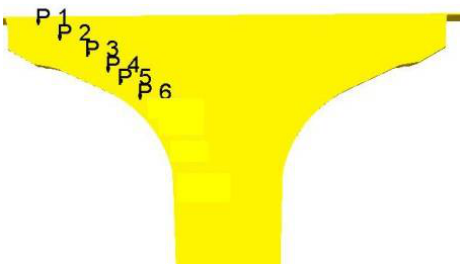
Figure 13. Forging valve profile.